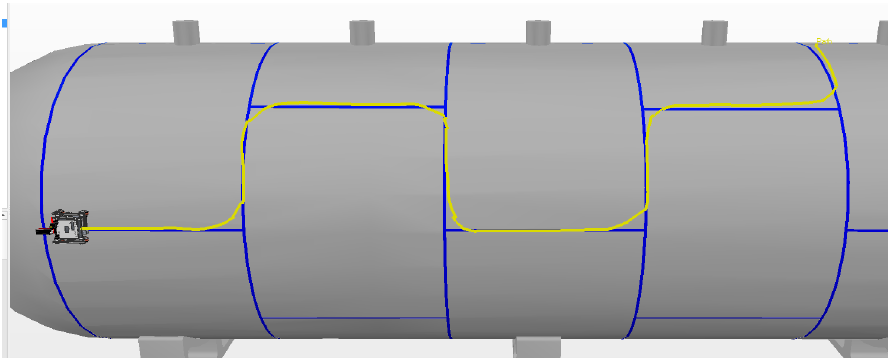
Figure 19. Manual Mode. The yellow line is the route traveled by the